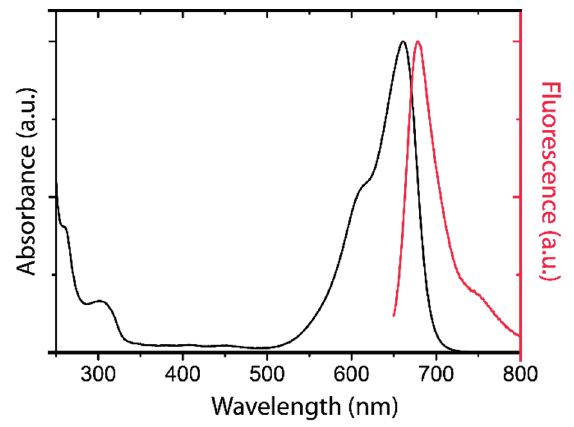
Figure 7. Absorption (black) and fluorescence emission (red) spectrum of